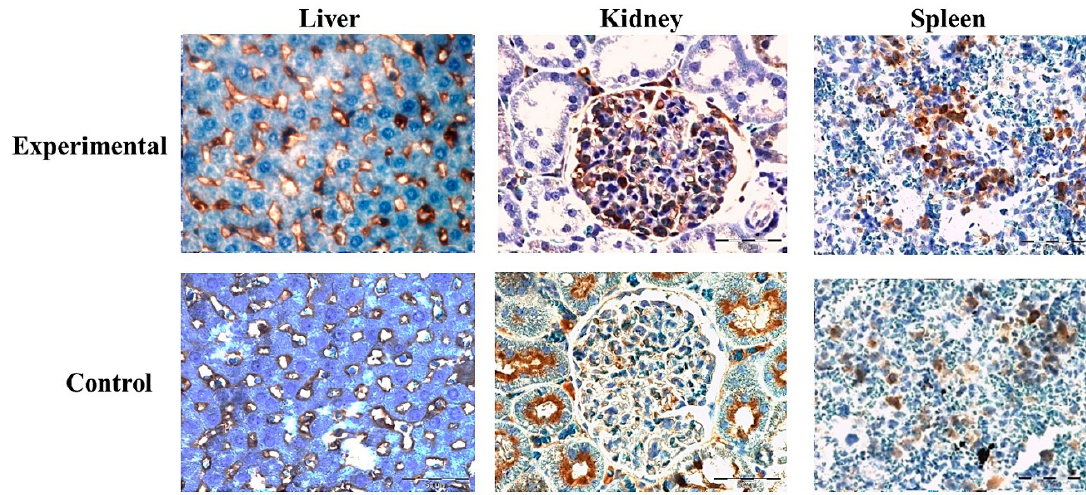
Figure 5. Representative images of Ki67 protein expression in rats’ liver, kidney and spleen tissue sections of experimental and control group, 40 × magnification. A significant expression of Ki67+ cells was observed in experimental group (brown colored cells).